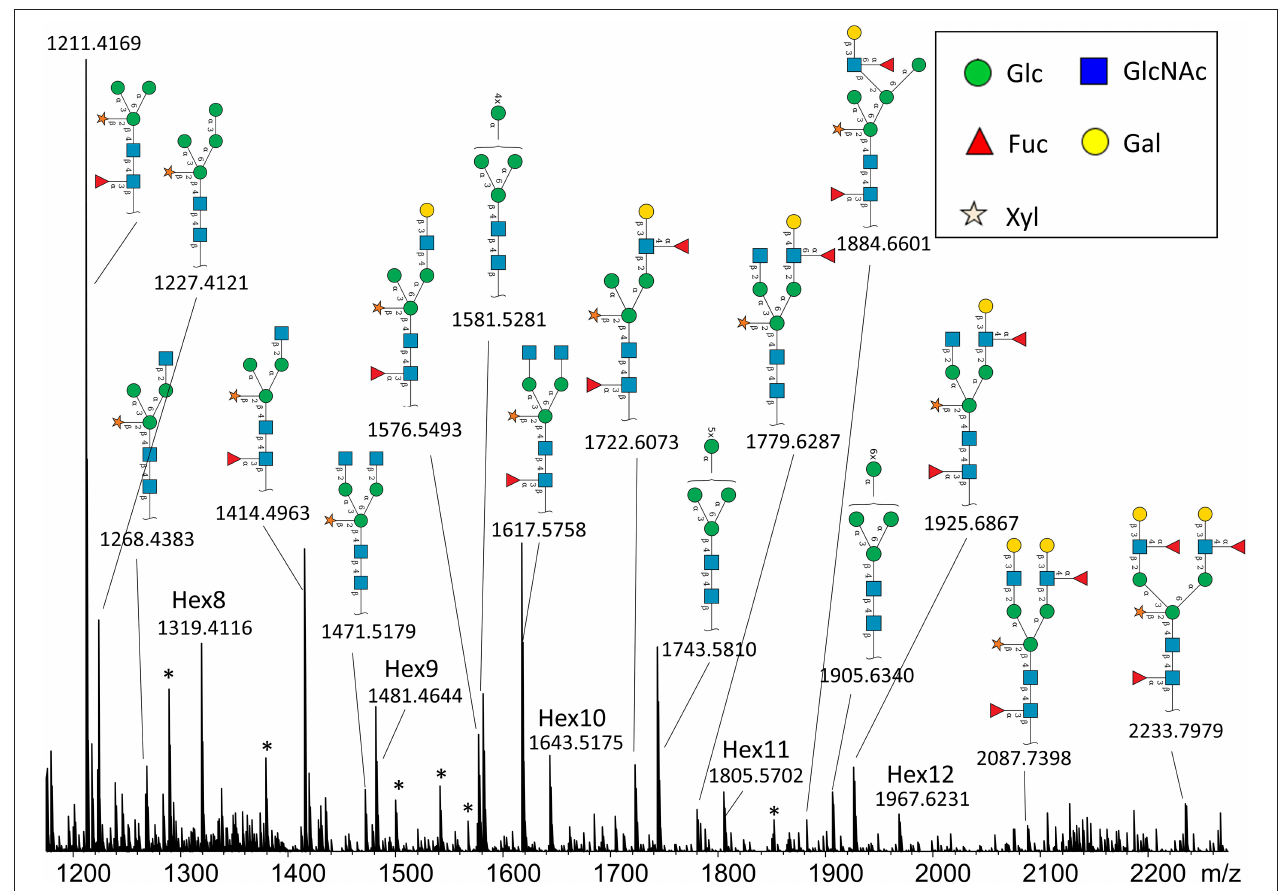
FIGURE 1 | Average MALDI imaging spectrum and Symbol Nomenclature for Glycans (SNGF) annotation of the most intense N -glycans from nifH- soybean root nodule treated with PNGaseH + . Note that some peaks are annotated as hexose oligomers (Hex8-Hex12), and they probably originate from starch or cellulose. There are also some unidentified peaks (labeled with